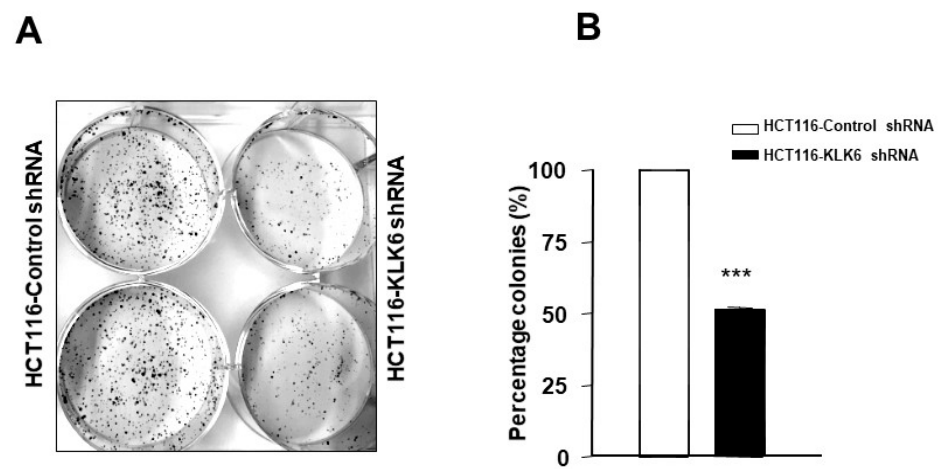
Figure 5. The effect of KLK6 knockdown on colony formation. ( A ) HCT116-control shRNA and HCT116-KLK6 shRNA were plated as described in Materials and Methods and incubated for 12 days. Silencing KLK6 induced a strong decrease in colon cancer colony formation. Representative images were captured and quantified using an Azure™ Imaging Systems. ( B ) Analysis of colony formation rates is shown as percentage of colonies from three independent experiments, each performed in duplicate. Data are shown as mean ± SEM. *** p < 0.001.